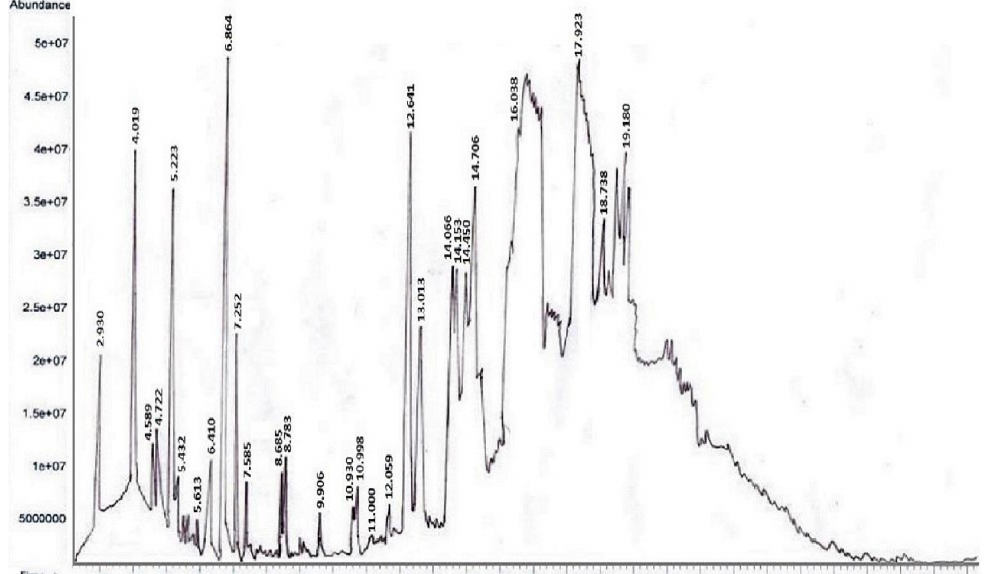
Figure 1. GC-MS chromatogram of n -Hexane extract from the leaf of C. oppositifolia.